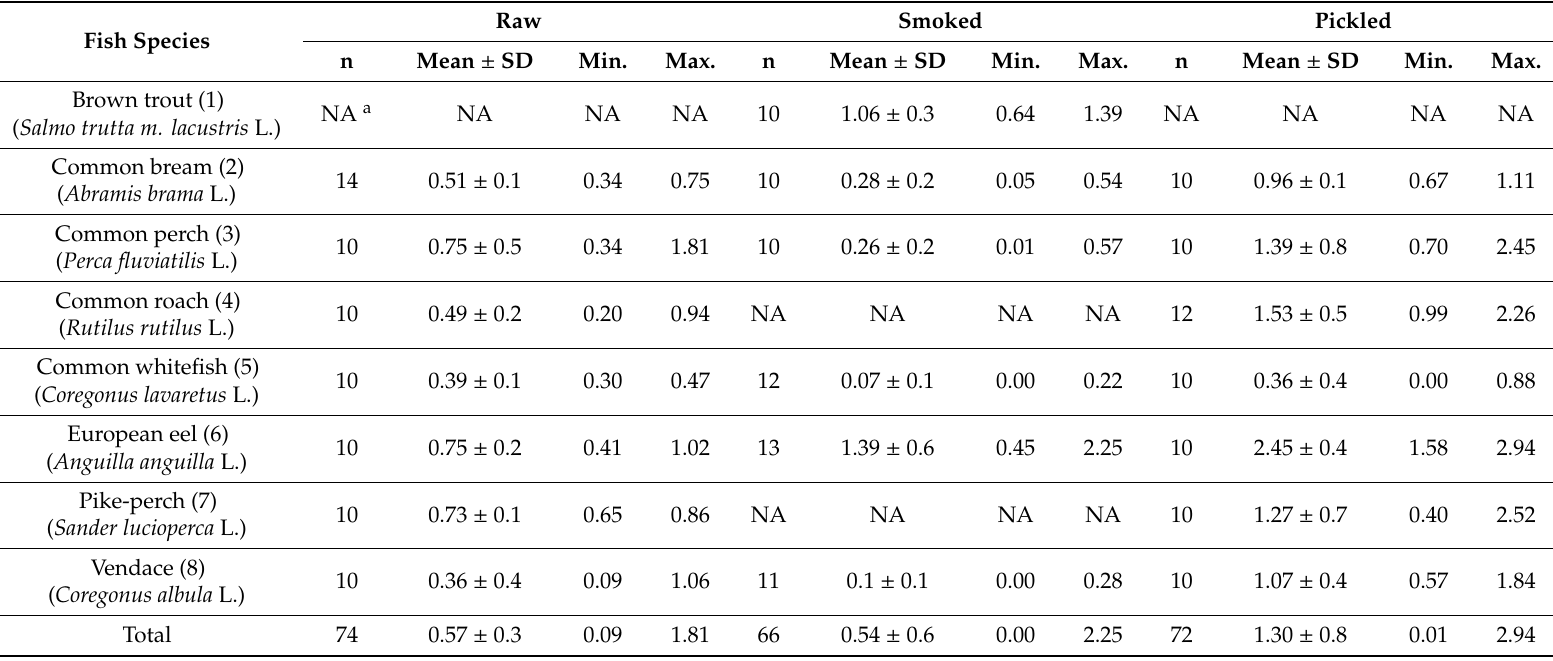
Table 4. Collagen content in raw, smoked and pickled fish product samples (g / 100 g). Raw Smoked Pickled Fish Species n Mean ± SD Min. Max. n Mean ± SD Min. Max. n Mean ± SD Min. Max.